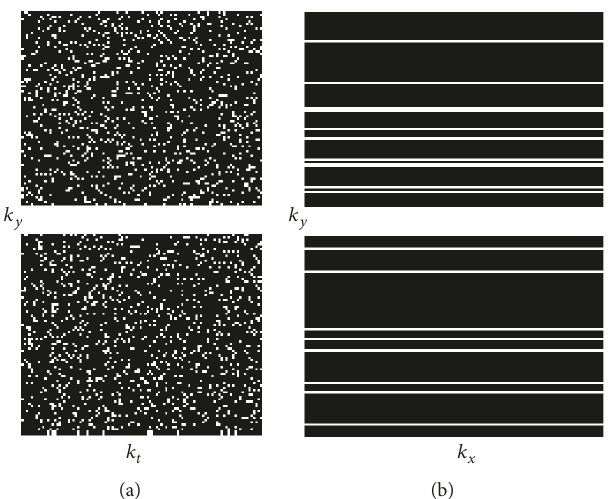
Figure 1: An example sampling pattern for all dynamics (a) and a 2D sampling for one dynamic (b). The 2D mask on (b) is generated by repeating one column of the mask on (a). For each dynamic, the central lines are fully sampled and the periphery is randomly sampled. The total undersampling factor is around 4.5.